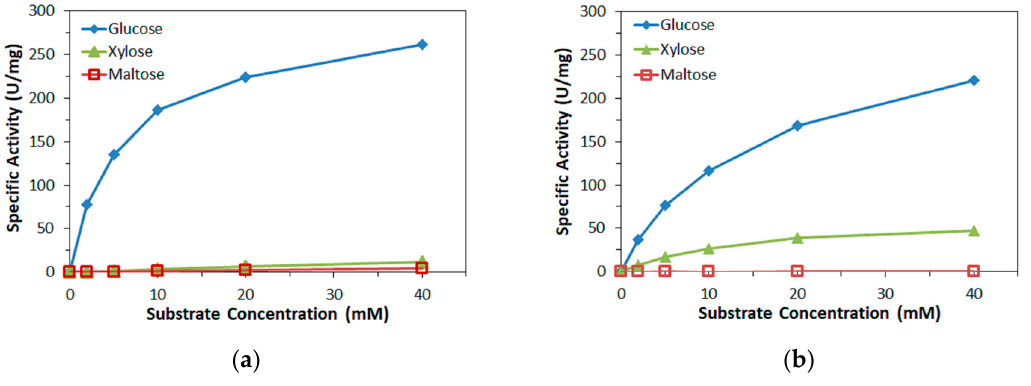
Figure 1. Dependency of specific activity on the concentration of three mono- and disaccharides for two FAD-dependent glucose dehydrogenases (FADGDHs). ( a ) bacterial FADGDH (FADGDH γαβ (QY)), ( b ) fungal FADGDH ( Af GDH).